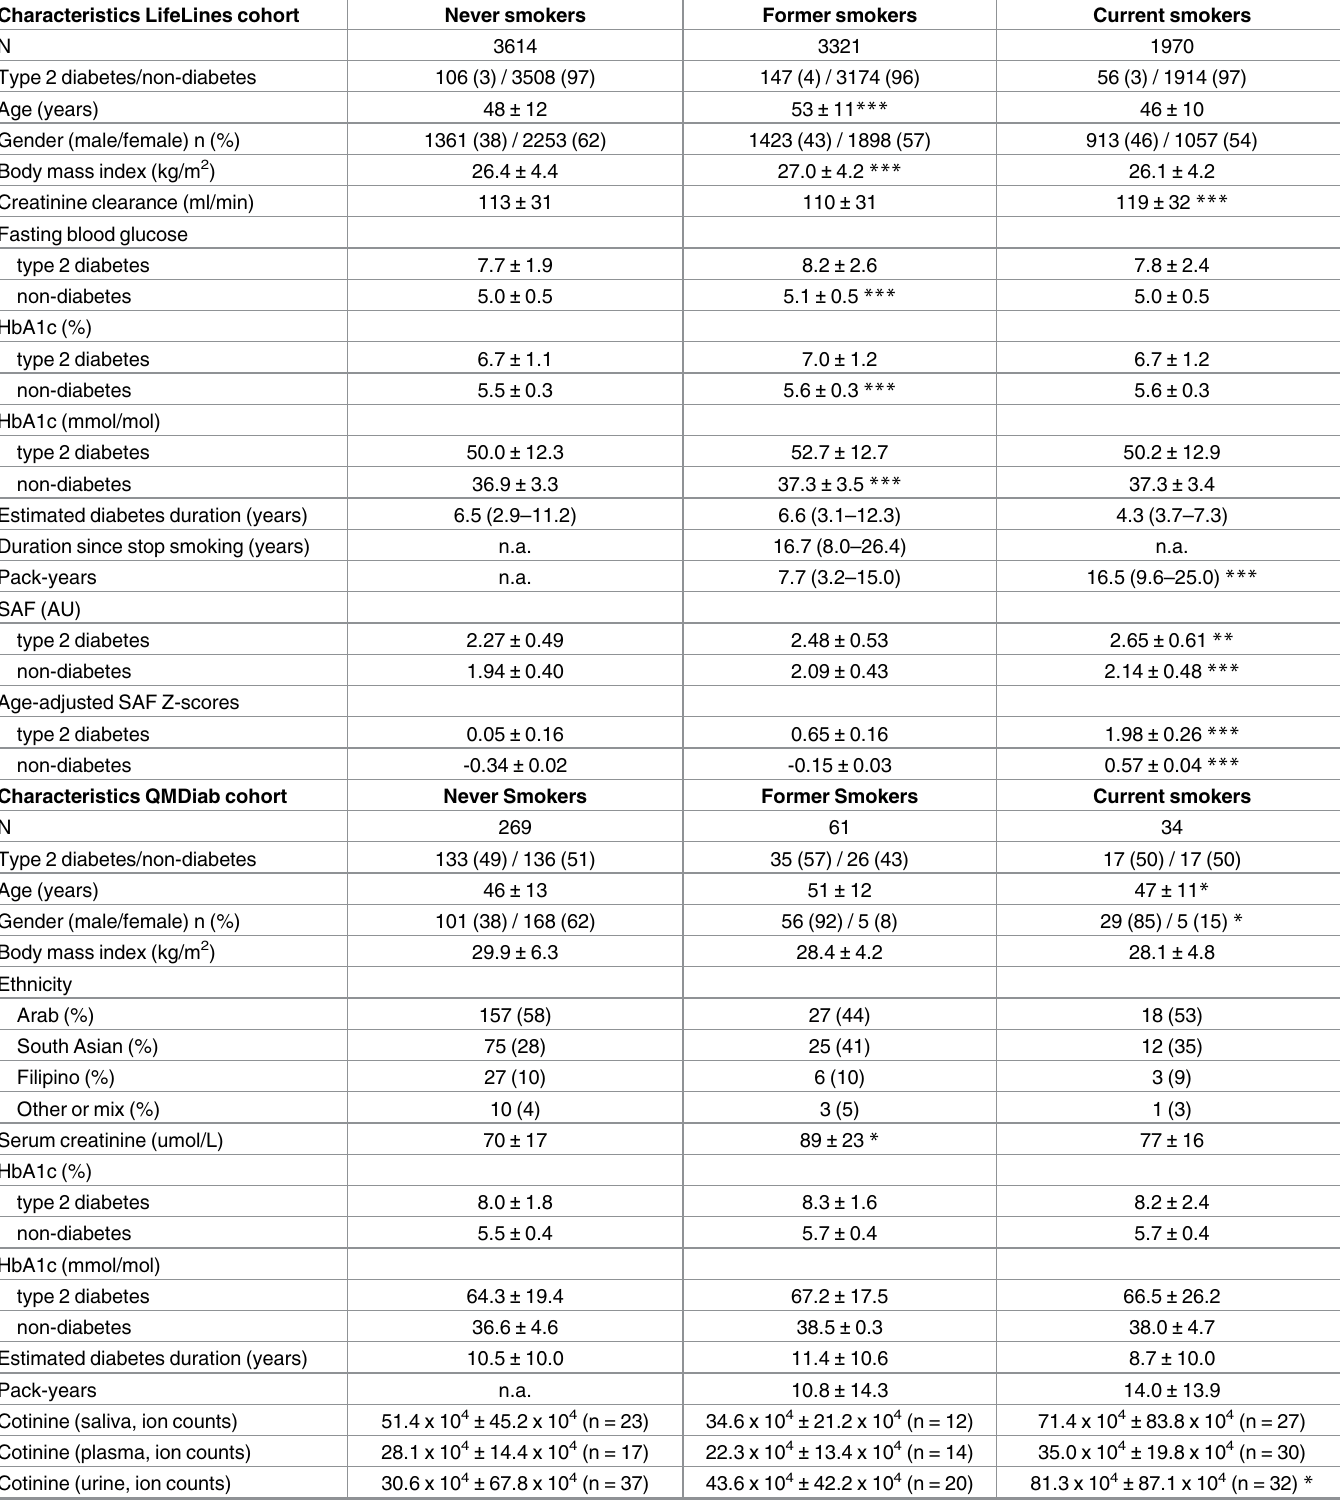
Table 1. Subjects characteristics of the study